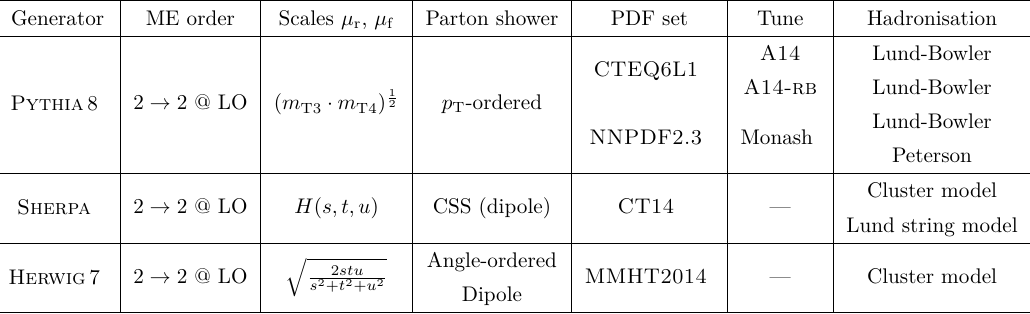
Table 1 . Properties of the Monte Carlo samples used in the analysis, including the perturbative order in α , the number of final-state partons, the PDF set, the parton shower algorithm, the s renormalisation and factorisation scales, the tune and the hadronisation model. Further details can be found in the